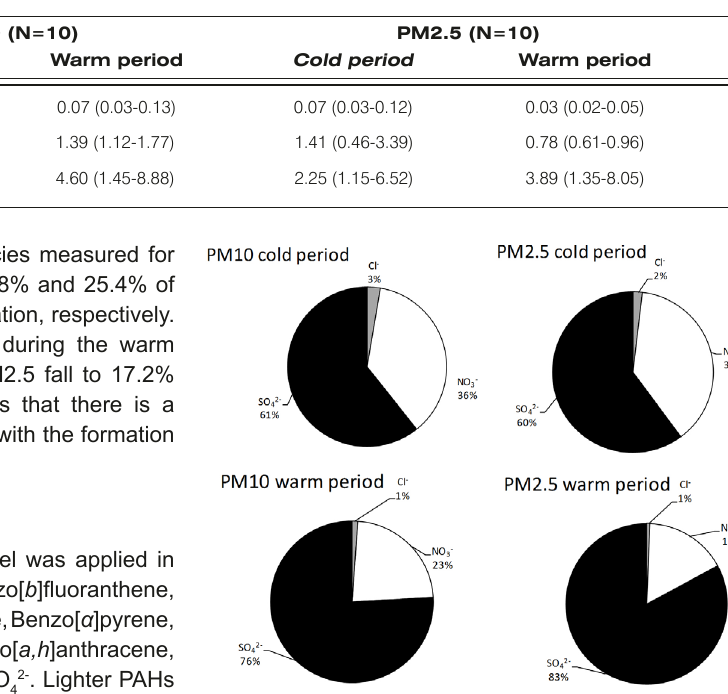
Table 4. Mean (min-max) concentrations of anionic components in PM10 and PM2.5 in winter and summer time at the sampling site (in μg m -3